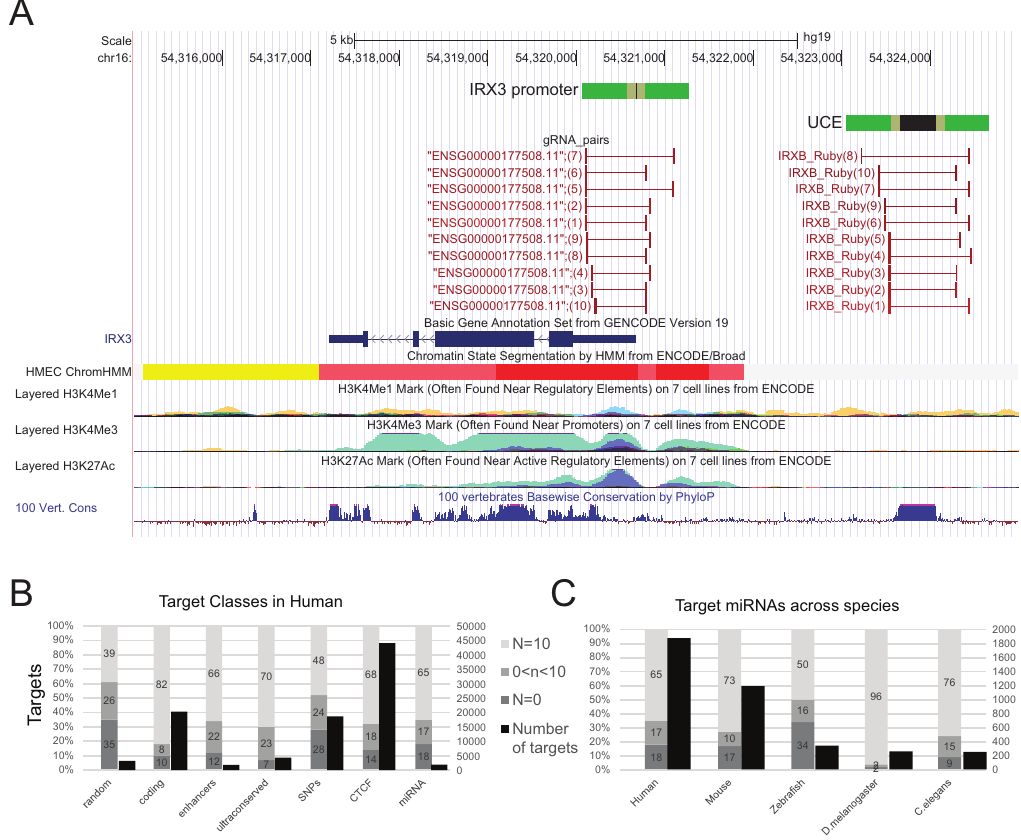
Fig 3. Genome-wide knockout libraries for entire classesof genomic elements in humans and other species. (A) An exampleof pairedsgRNAs designed against the upstream ultraconserved element (UCE) and promoterof the human IRX3 gene. IRX3 lies on the antisensestrand. The exact target regions are shown in black, flanked by the design regionsin green. The ten sgRNA pairs for each are denotedby red bars. Integrated chromatinmarks from the ENCODE project [26] are displayedbelow, in additionto PhyloP multispecies conservation scores [33]. Note the regionof elevatedconservation corresponding to the UCE. (B,C) Summary of pairedsgRNA designs targeting entire classes of genomicelements. In each figure, the left scale and grey bars representthe design performance, as in Fig 2. The right scale and black bars indicate the total number of elementsin each class. (B) shows a series of genomic elementclasses for human, while(C) shows designs for the entire set of annotated microRNAgenes in five species. Designs were created with default settings; designsusing “DECKO” constructionmethod give